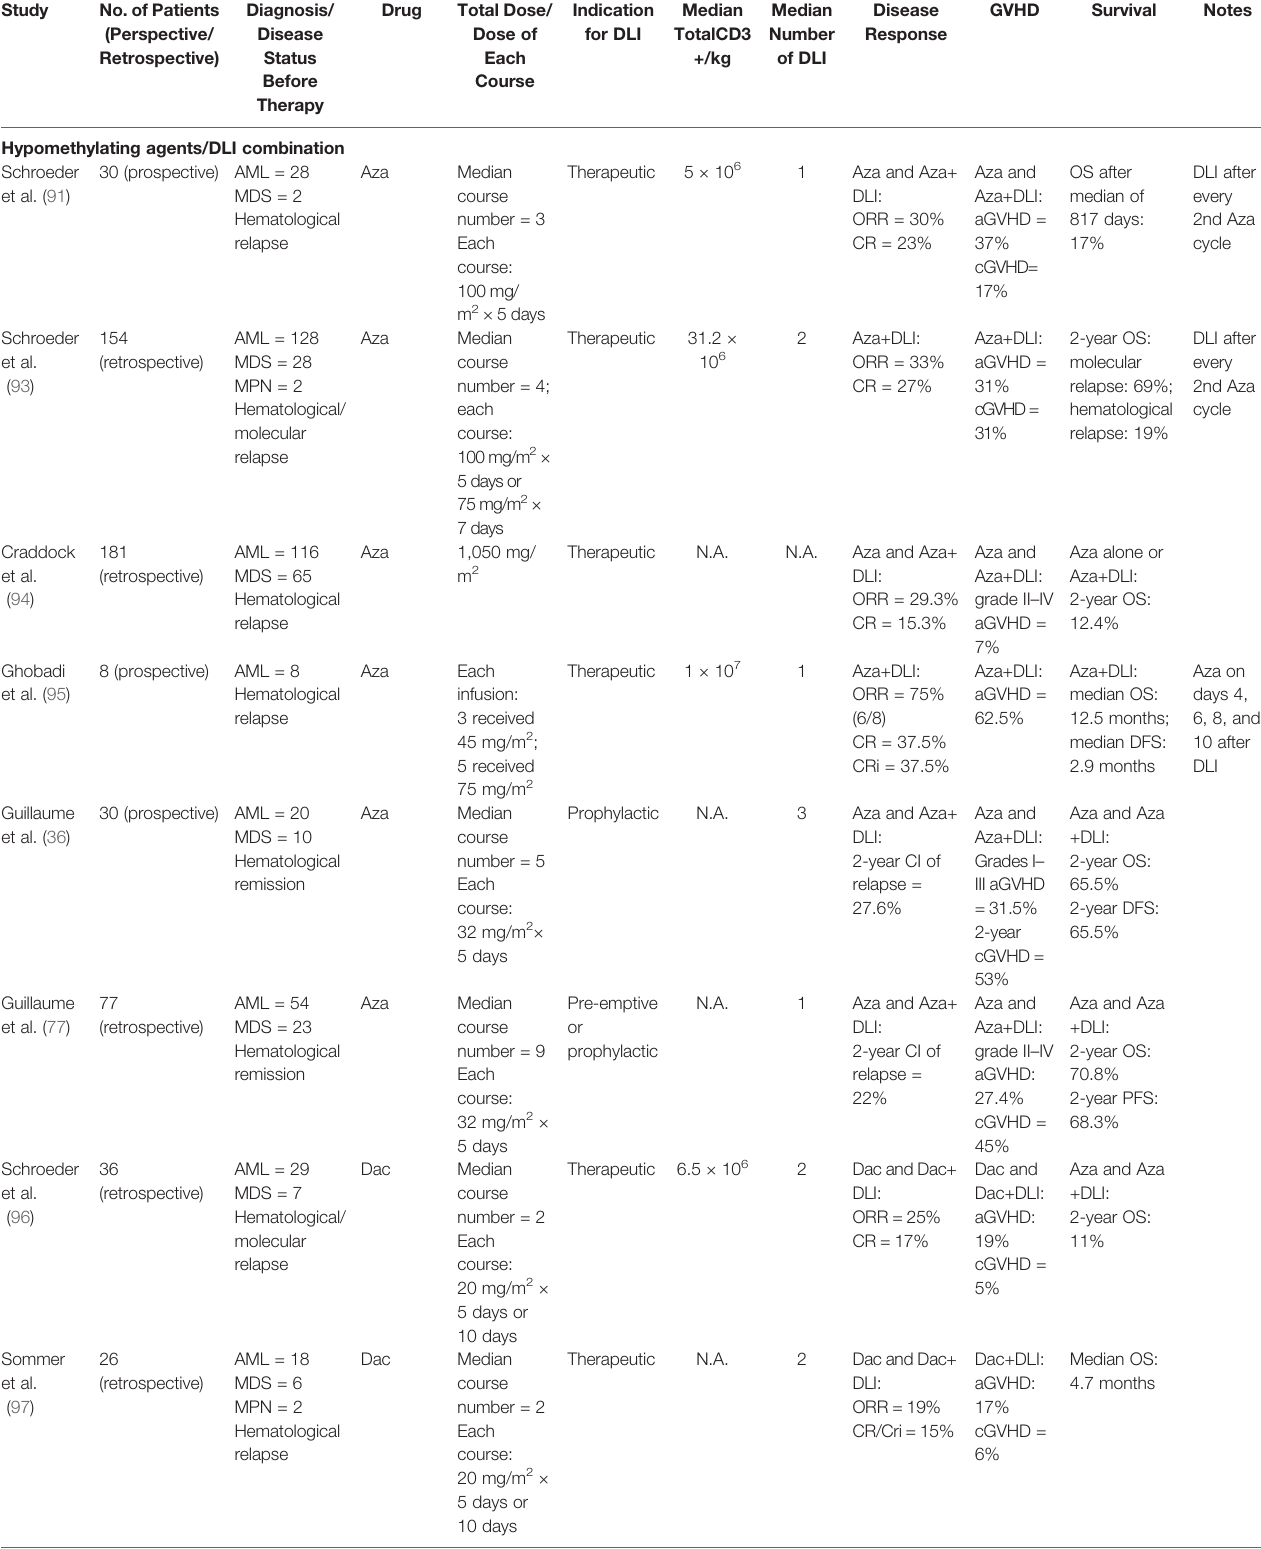
TABLE 1 | Published studies on new drugs/DLI combined use for AML relapse after